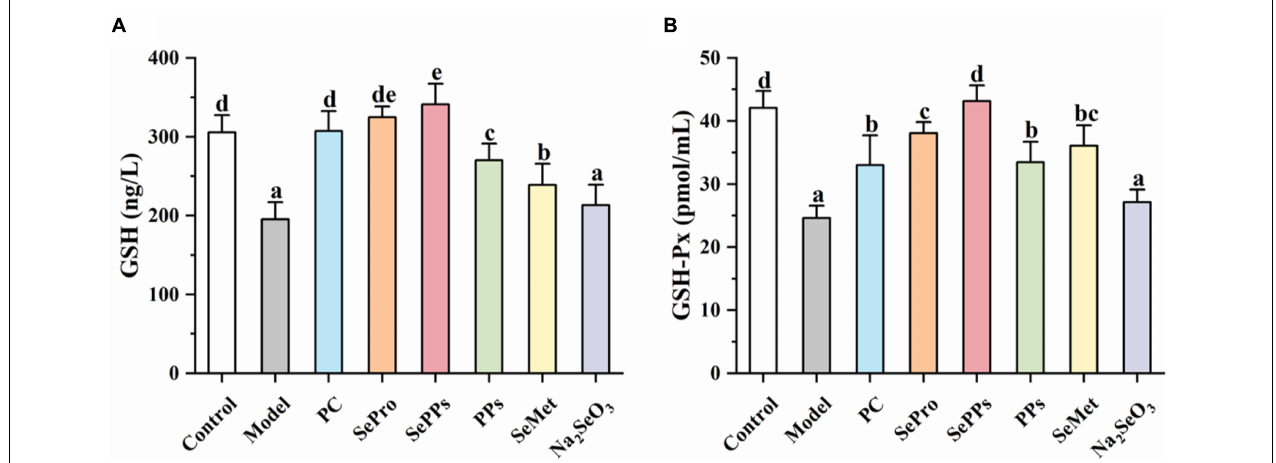
FIGURE 4 | Effects of different selenium supplements on GSH (A) and GSH-Px (B) in rat liver. Values are expressed as the mean ± SD, results marked with the same letters were not significantly different ( p >